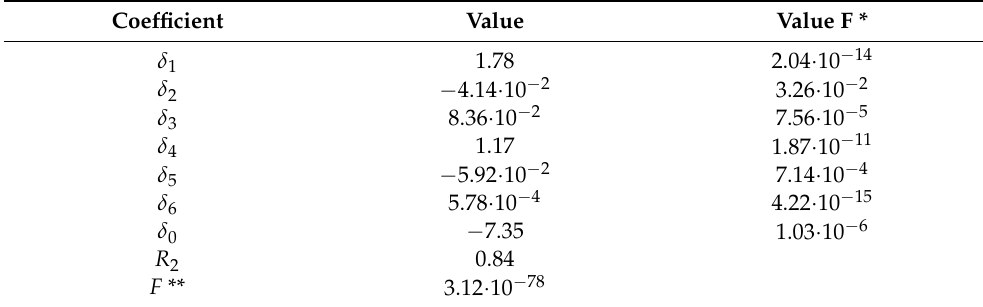
Table 4. Summary of statistical test results for the disc brake friction pad wear model after verification of model coefficients.